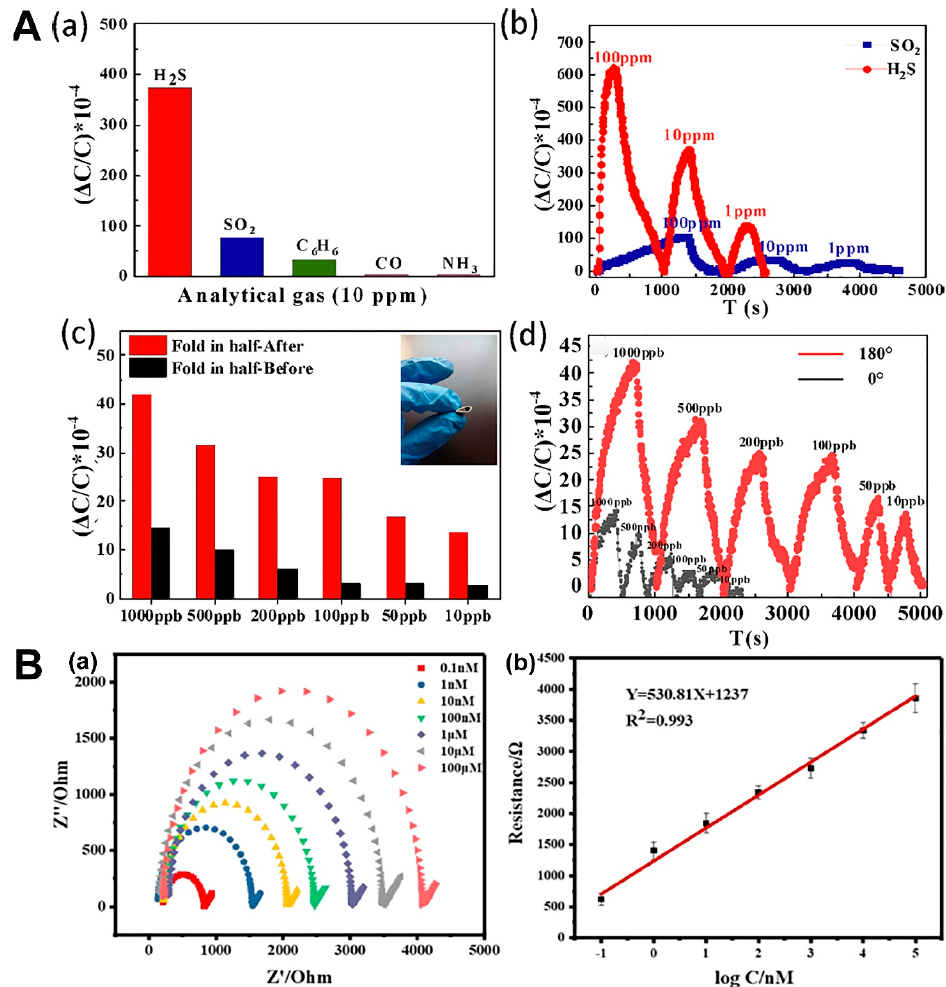
Figure 3. Application of electrochemical detection sensors in environmental pollution. ( A ) ( a ) Eval- uation of the selectivity of the NO 2 -UiO-66 nanomaterial sensor toward H 2 S. ( b ) Detection of varying concentrations of H 2 S and SO 2 , using the NO 2 -UiO-66 nanomaterial sensor. ( c ) Analysis of the ca- pacitive variations exhibited by the sensor under normal conditions and when subjected to 180° bending. ( d ) Investigation of the cyclic stability of the sensor for different concentrations of H 2 S while subjected to bending (reproduced with permission from [52], copyright © 2022, Elsevier). ( B ) ( a ) Investigation of the impedance responses of the aptasensor toward various concentrations of TC, using EIS. ( b ) Generation of a calibration curve for the quantitative detection of TC, using the ap- tasensor (reproduced with permission from [41], copyright © 2022, Elsevier).